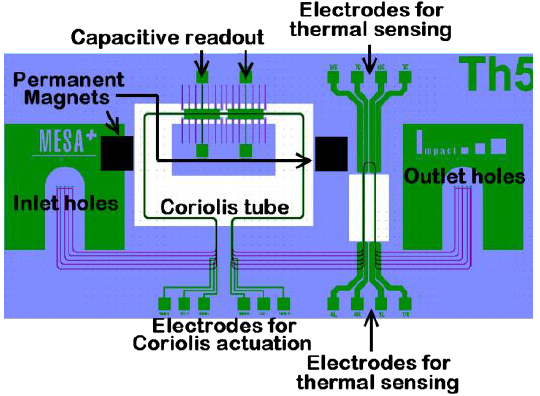
Figure 1. Structure of integrated thermal and microCoriolis flow sensing